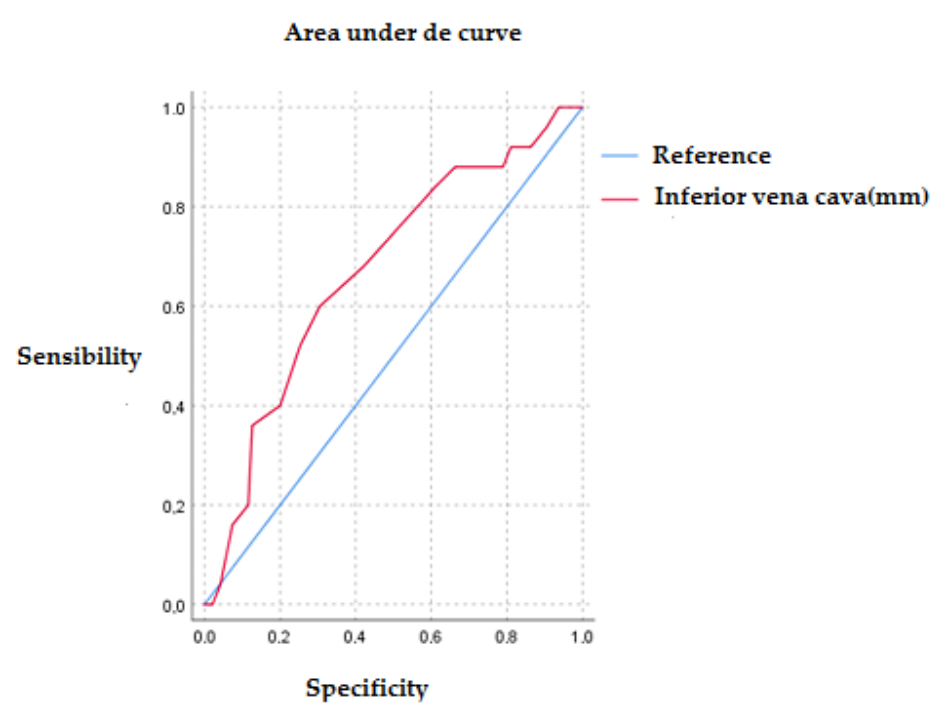
Figure 1. Analysis of the area under the curve for inferior vena cava diameter (mm) and 30-day mortality.